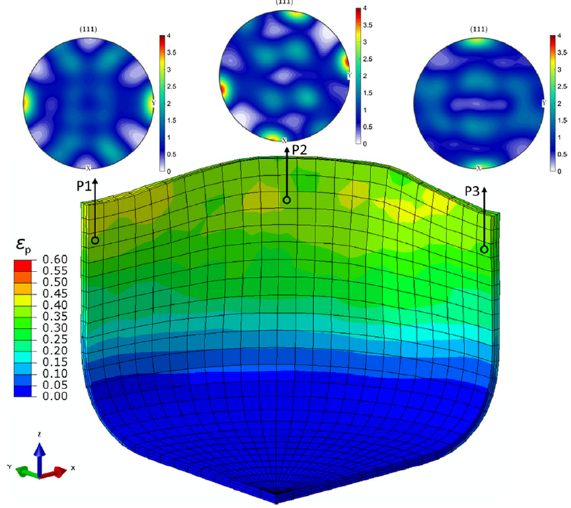
Figure 13. Equivalent plastic strain distribution and textures at three cup positions simulated with the evolving Yld2004-18p yield function calibrated from the CP model. Reprinted from Ref. [203] with permission. Copyright 2020, Elsevier.